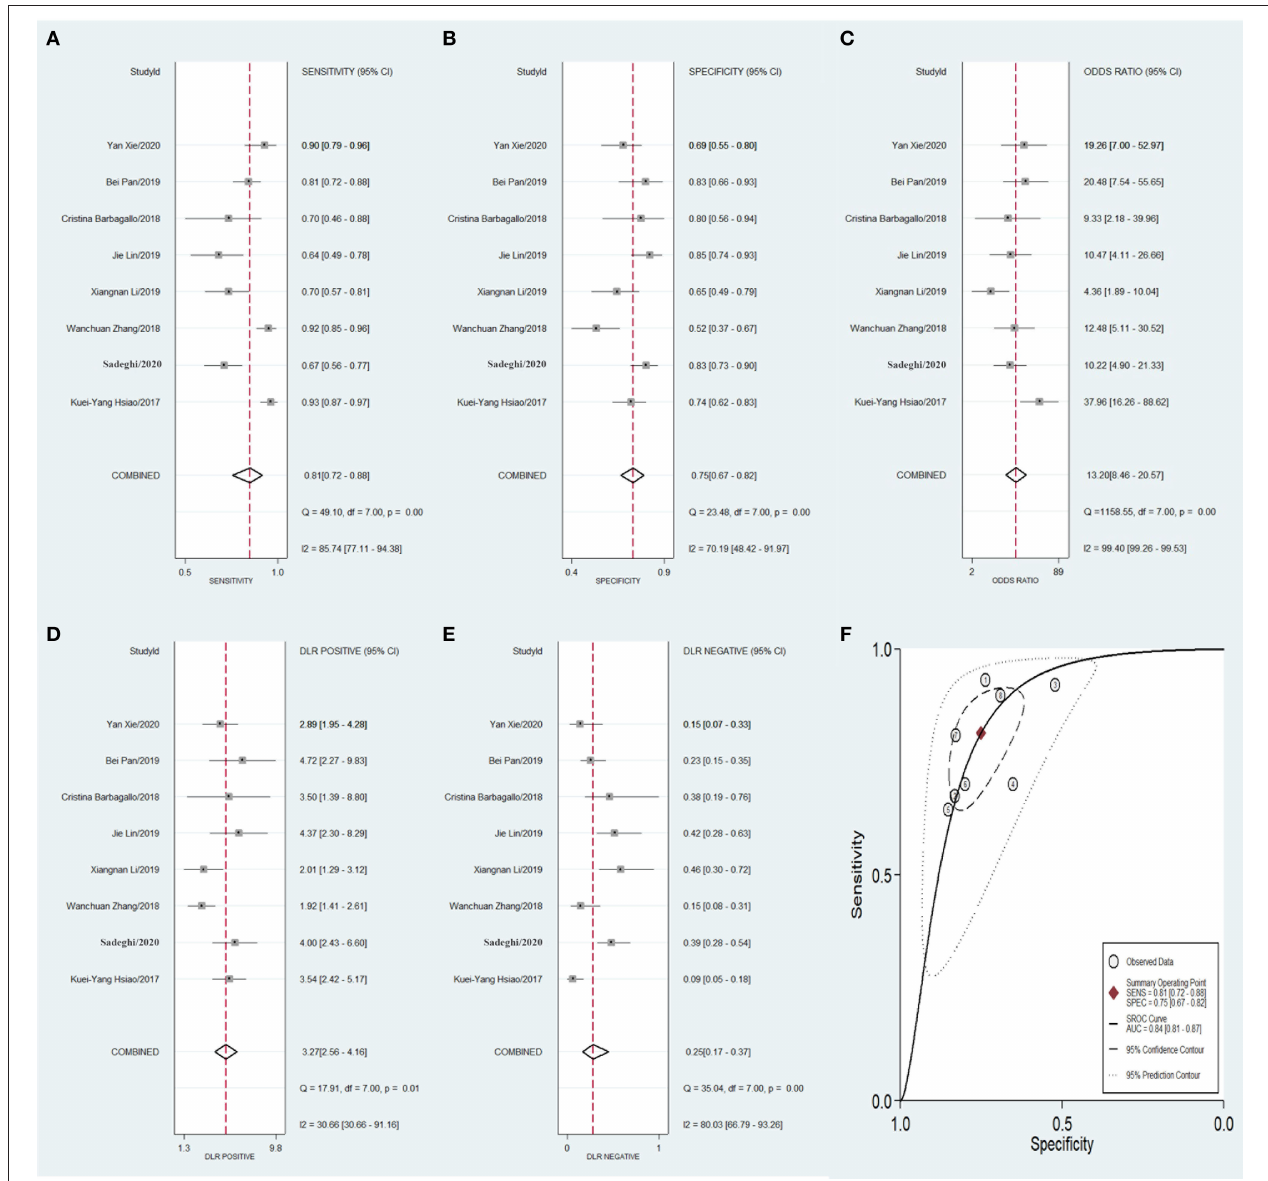
FIGURE 6 | Forest plots of pooled diagnostic power of up-regulated circRNA as a biomarker for colorectal cancer, (A) Sensitivity, (B) Specificity; (C) DOR; (D) PLR; (E) NLR and (F) AUC. DOR, diagnostics odds ratio; PLR, positive likelihood ratio; NLR, negative likelihood ratio; AUC, the area under receiver operating characteristics